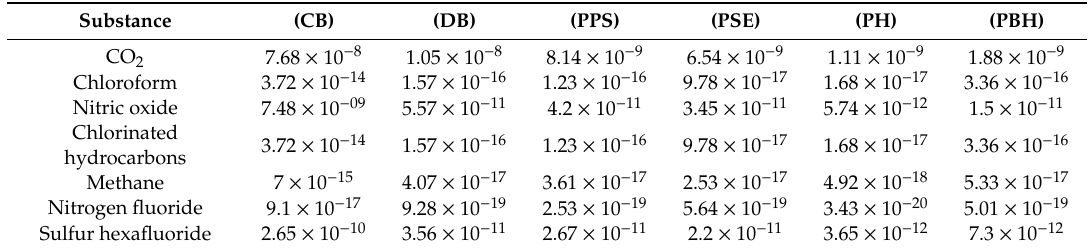
Table 5. Results of characterization of environmental impacts for the category of global warming,